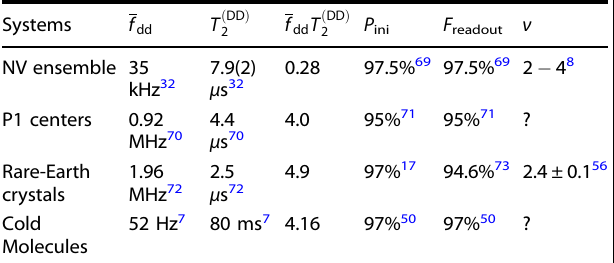
Table 1. Parameters of different experimental